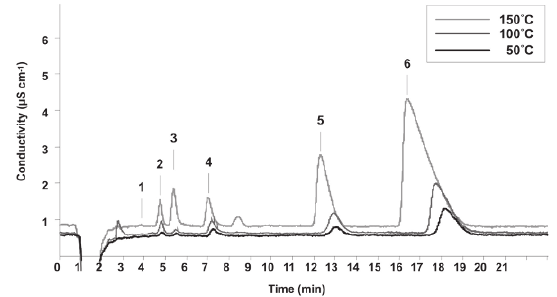
Figure 2. The comparison of chromatograms of the soil extracts provided by MAE at different temperatures. Cation, peak No: lithium, peak 1; sodium, peak 2; ammonium, peak 3; potassium, peak 4; calcium, peak 5; magnesium, peak